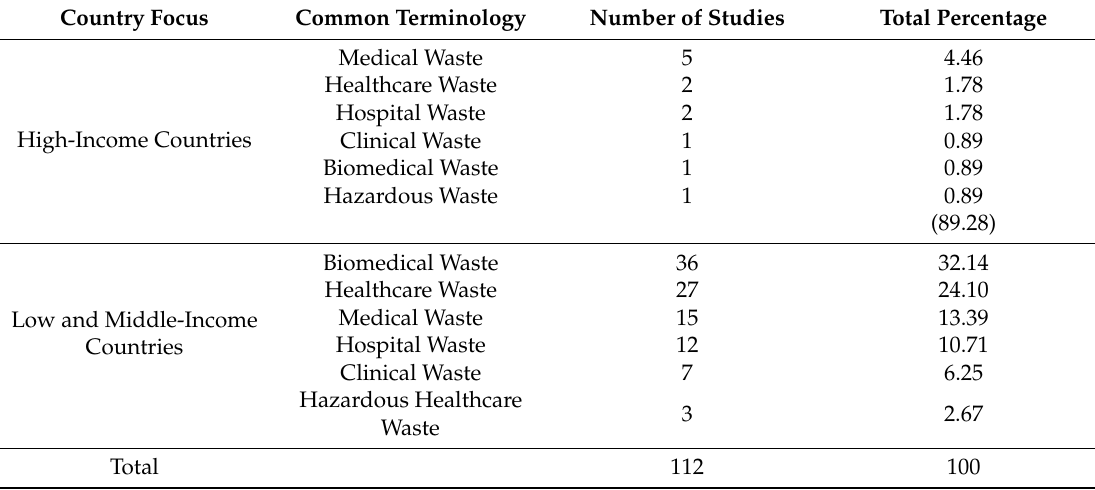
Table 2. The common terminologies used by LMICs and HICs to describe healthcare waste. Country